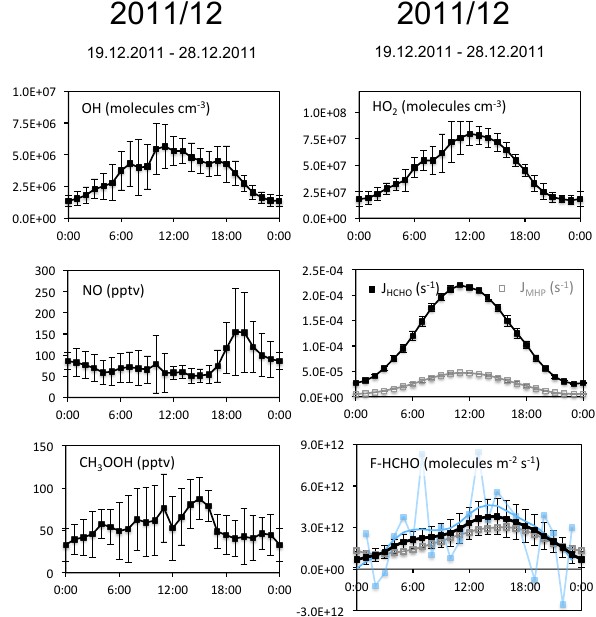
Figure 8. Diurnal cycles (hours are LT) of key input parameters used in 1-D simulations discussed in Sect. 6. J HCHO denotes the sum of J HCHO-mol and J HCHO-rad (see Table 1). HCHO fluxes (F- HCHO) used in the model were taken as the mean (black dots) of F- HCHO derived from atmospheric HCHO gradients (blue dots) and from those derived from firn air atmosphere gradients (grey dots). Vertical bars refer to daily variability and to the uncertainty in cal- culations in the case of F-HCHO. OH and HO 2 data are from Kukui et al. (2014), and those of NO are from Frey et al.